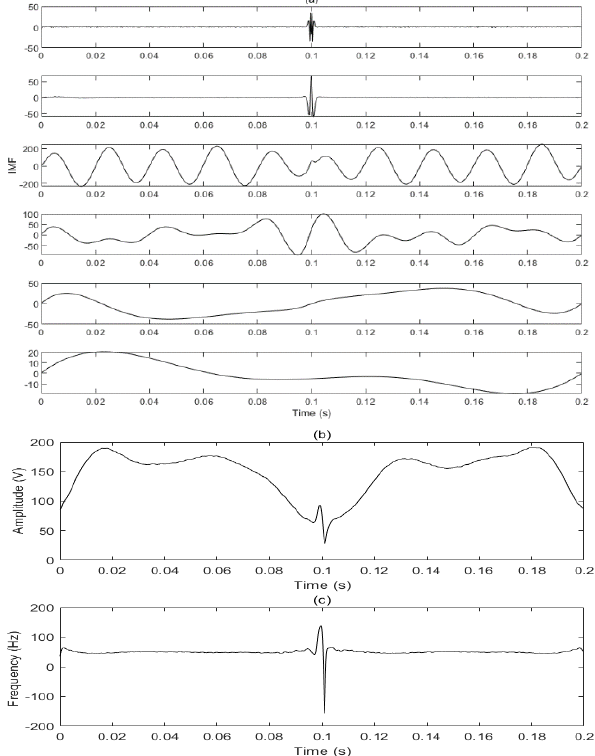
Figure 13. Impulsive transient IMF components ( a ), amplitude ( b ), and frequency ( c ).